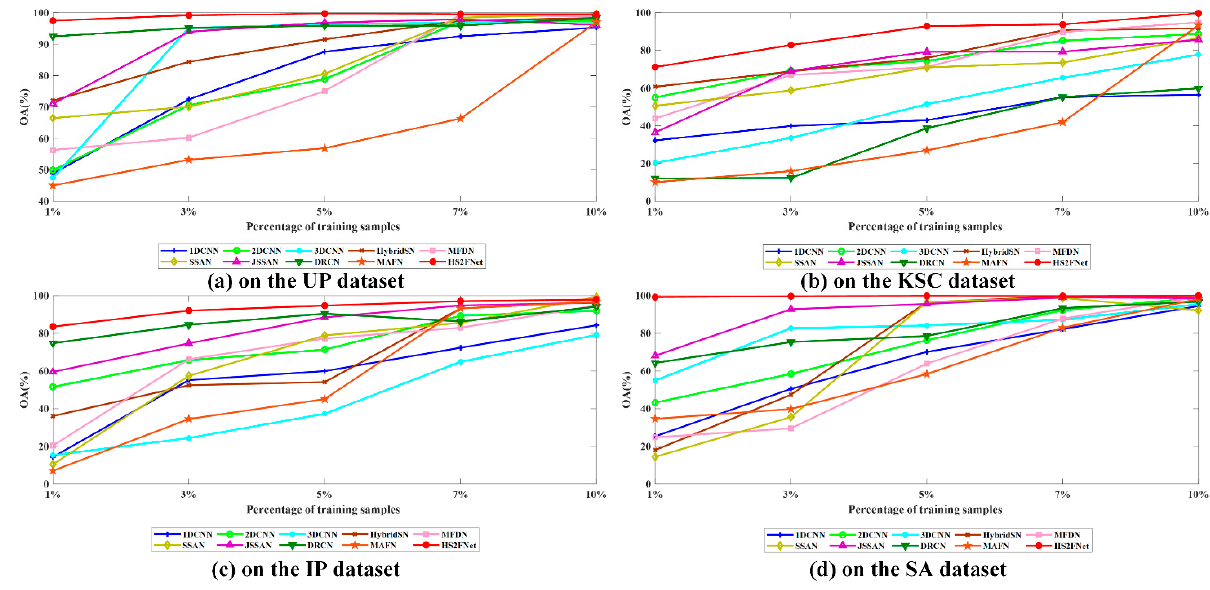
Figure 14. OA of various approaches with diverse numbers of training samples on four experi-